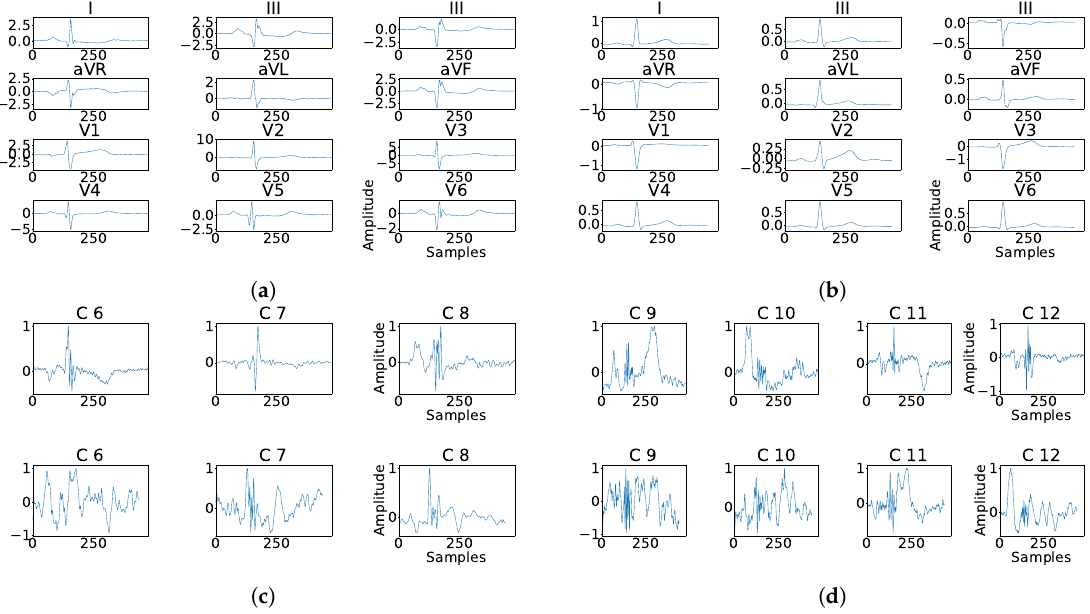
Figure 18. Example of fragmentation wave enhancement over real fragmented case. ( a ) Beat templates for each lead of real fragmented case. ( b ) Beat templates for each lead of control case. ( c ) Results of the best PCA method for the real fragmented case, in top subpanels and control case in bottom panels. ( d ) Results of the best ICA method for the real fragmented case, in top subpanels and for the control case in bottom